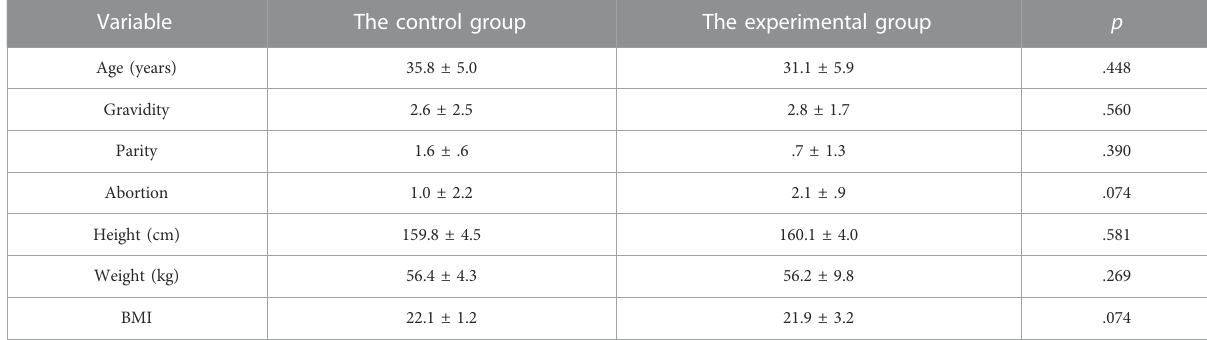
TABLE 1 Comparison of baseline characteristics between the control group and the experimental group for sequencing analyses.